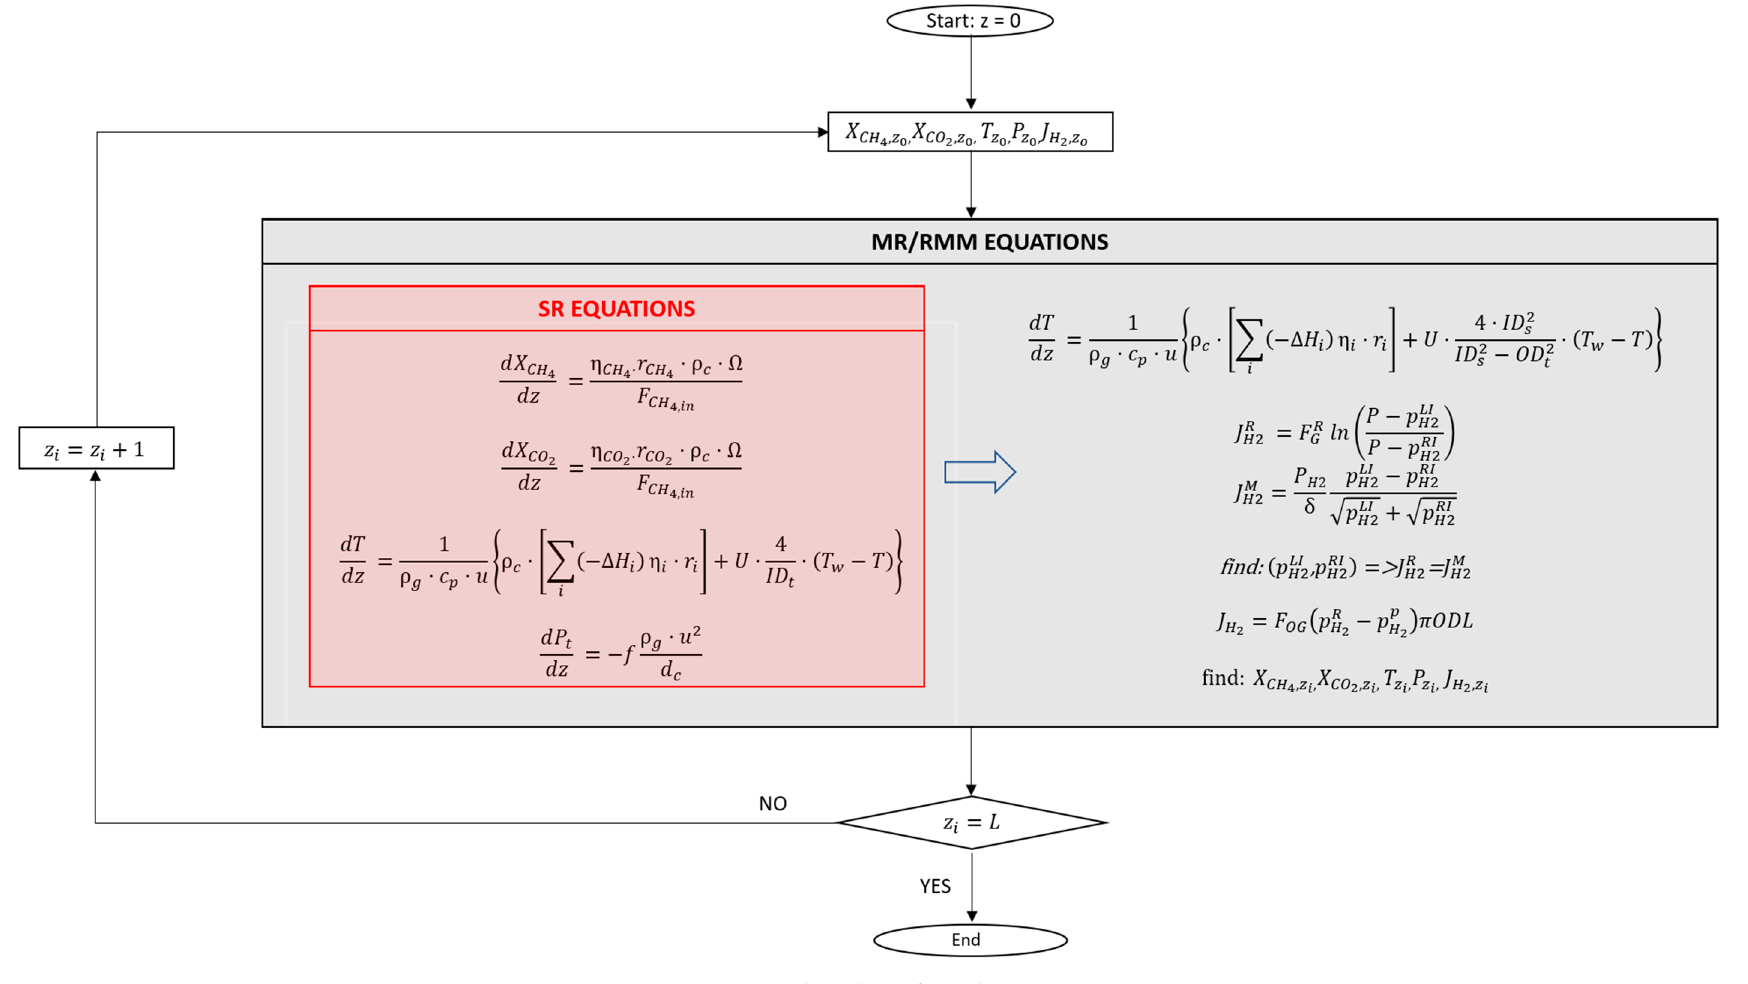
Figure 2. Flow chart of simulation.